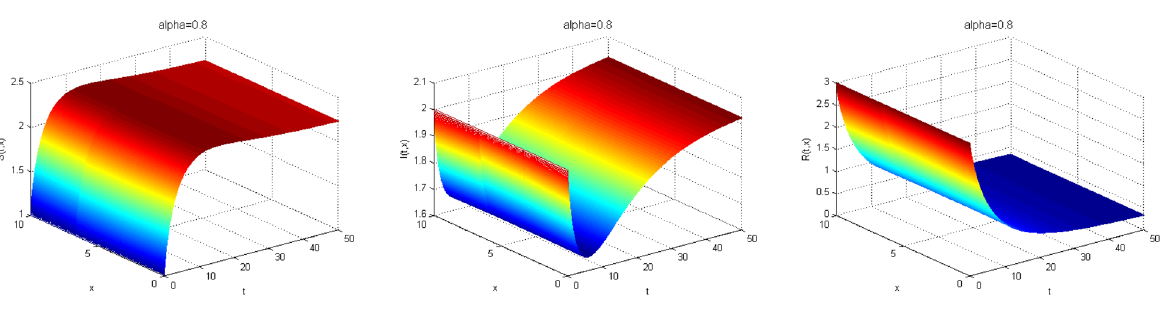
Figure 5. Dynamics of the system (3.2) for α = 1 .